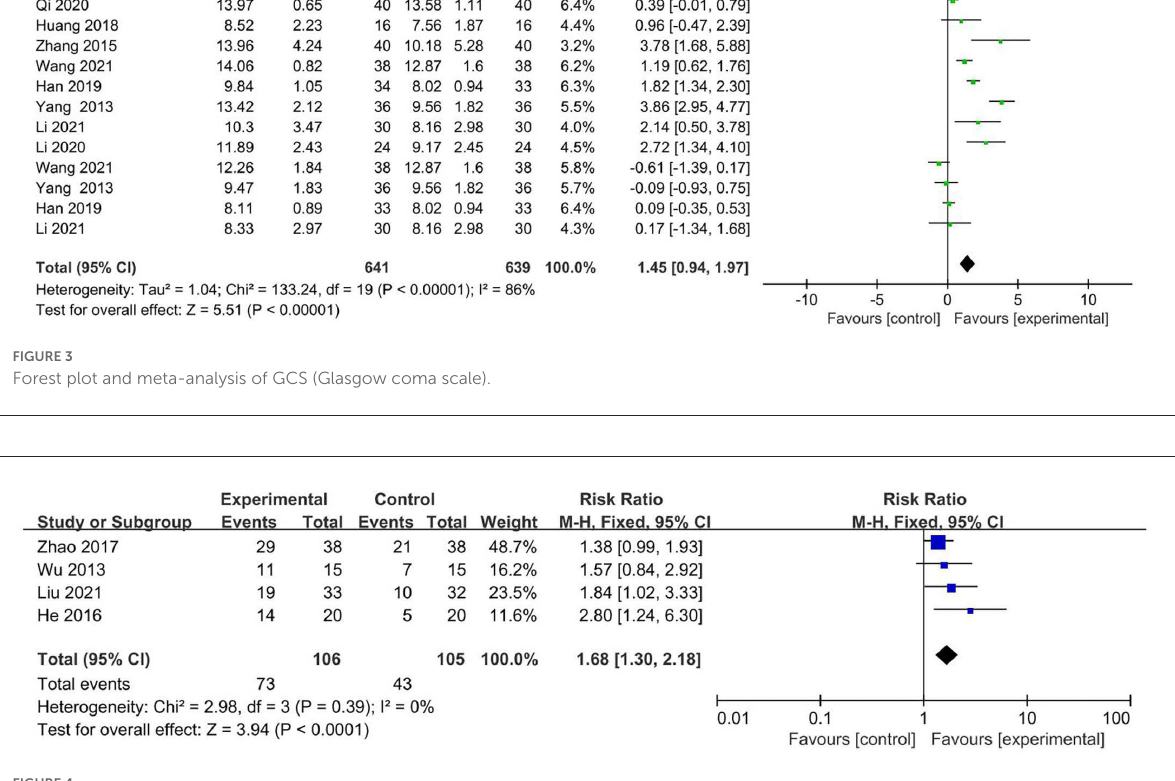
FIGURE4 Forest plot and meta-analysis of resuscitation